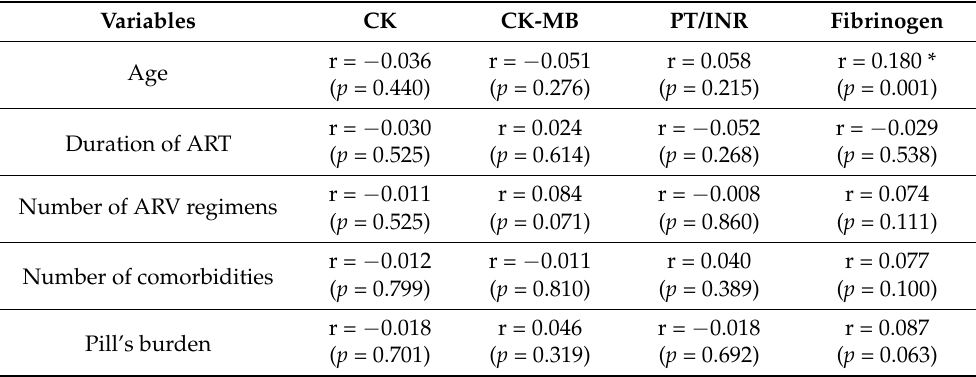
Table 8. Pearson correlation on the risk of heart markers and coagulation in HIV + cohort patients (N =